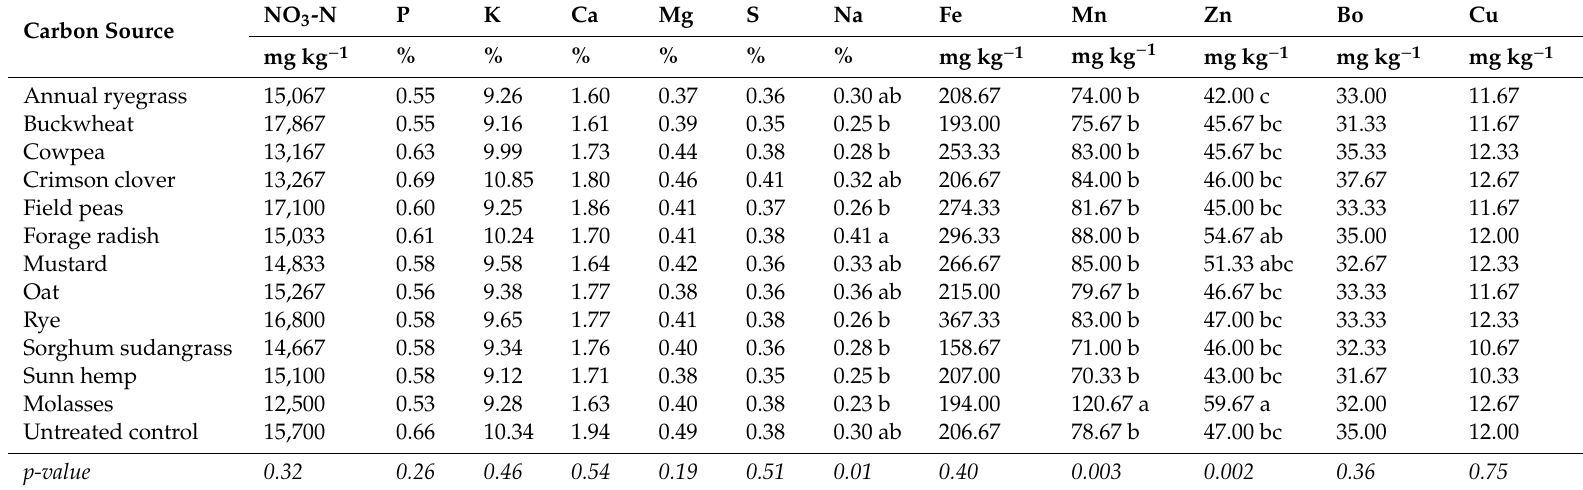
Table 9. Macro and micronutrient concentration at harvest (24 days after planting) of Salanova lettuce grown on anaerobic soil disinfestation treated soil amended with various C sources 1